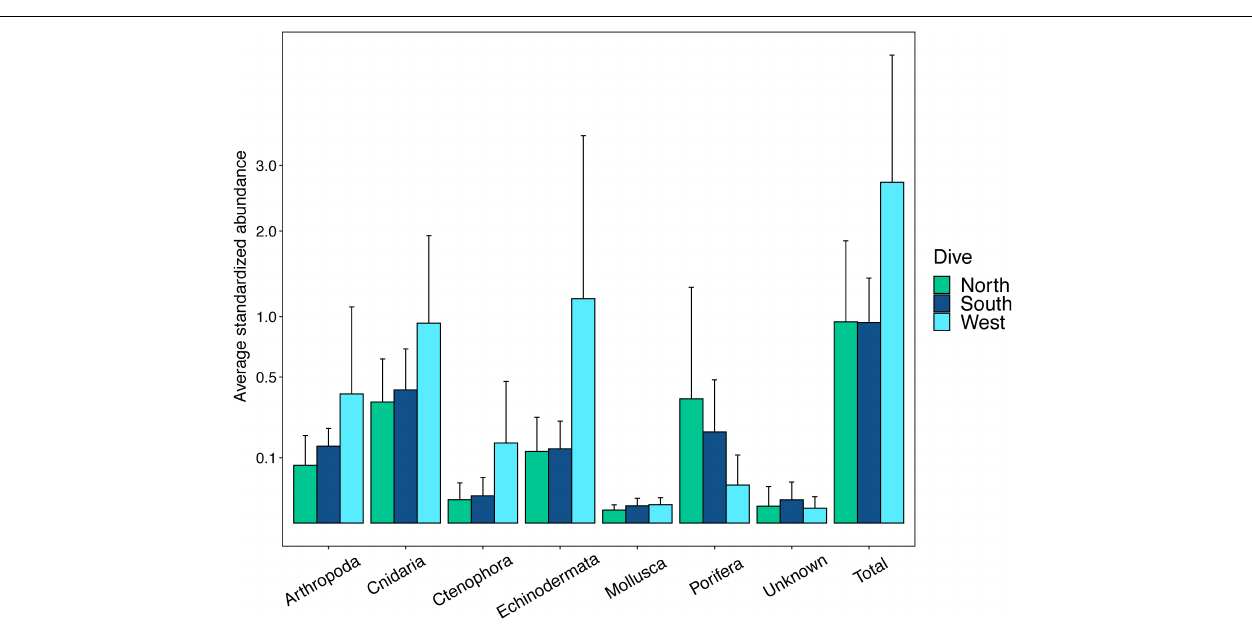
between depth bins (global R = 0.80, p = 0.001) and sides of the seamount (global R = 0.807, p = 0.001). Pairwise comparisons showed significant differences between all pairs of depth bins and between all comparisons of the sides of the seamount ( Supplementary Table S6 ).